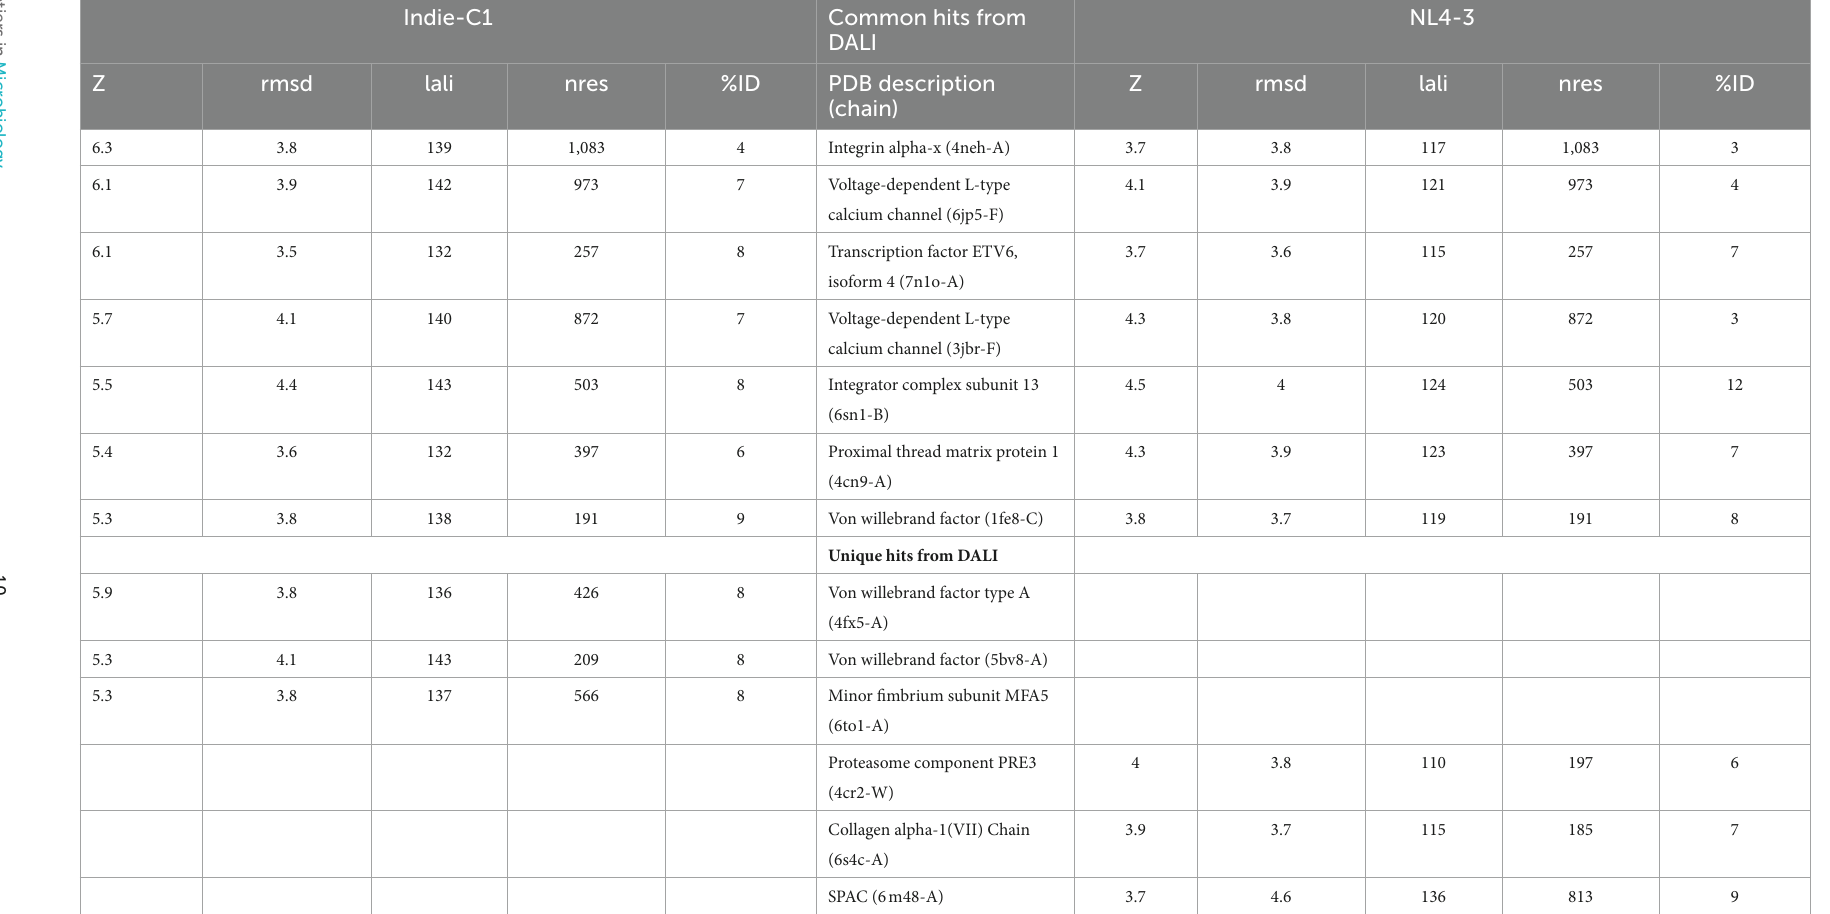
TABLE 1 List of common and unique hits from DALI for Indie-C1 and NL4-3. Indie-C1 Common hits from